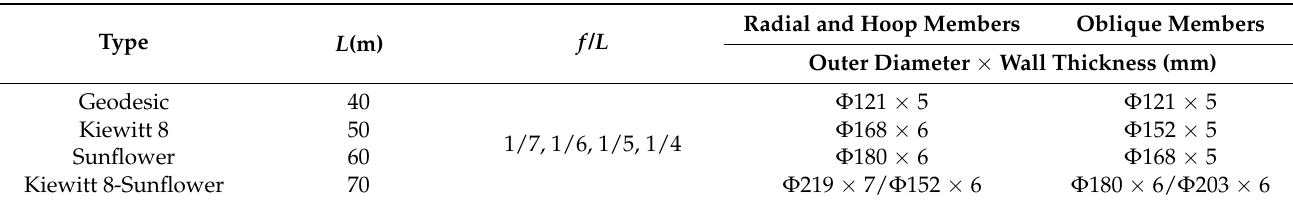
Table 2. Maximum SCL under different IGDMs.